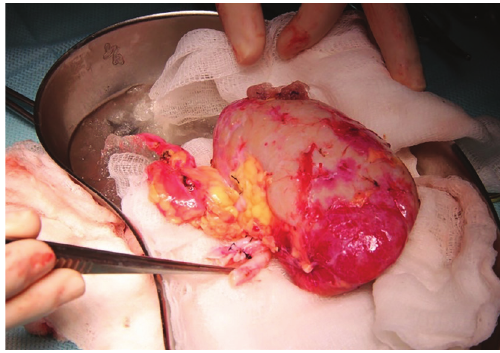
Figure 8 - Antegrade left pyelography